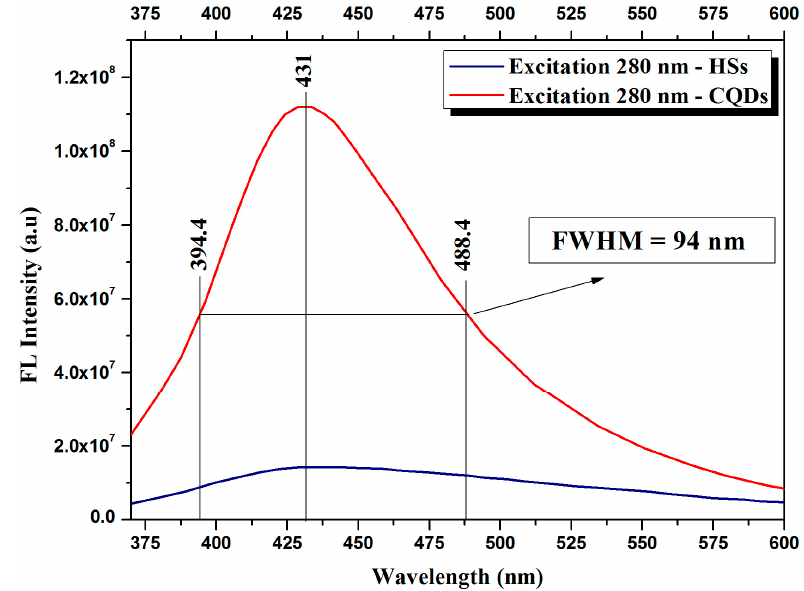
Figure 9. Comparison between the maximum emissions of the samples containing HSs (blue curve) and CQDs (red curve), and width at half maximum of the CQDs’ curve.